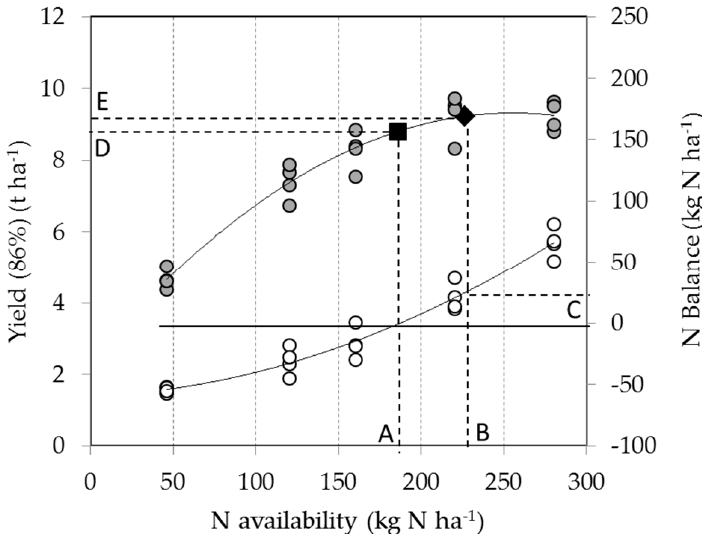
Figure 1. Yield (grey filled circles) and N balance (open circles) response to increasing N availability exemplified by data from site 16 (see Table 1). The filled square and diamond indicate points on the yield response curve where the N balance is zero and the yield is at economic optimum, respectively. Points A and B indicate N availability at these two points, point C the surplus at economic optimum and points D and E yields.